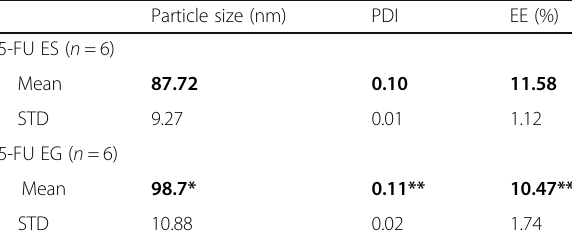
Table 1 Characterization of 5-FU ES and 5-FU